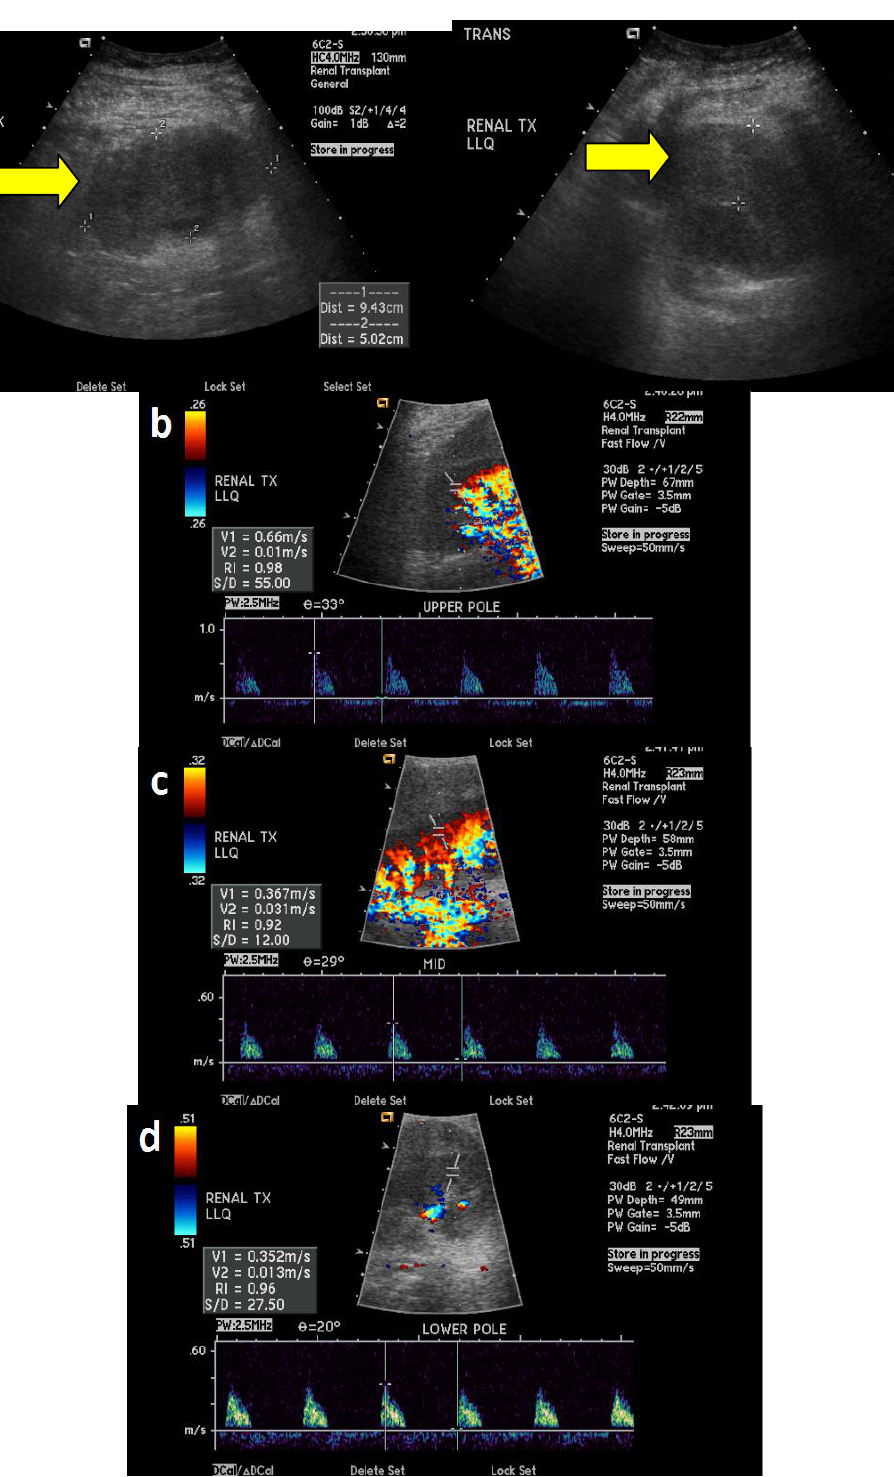
FIGURE 1. Transplant kidney ultrasound showing a large subcapsular perinephric concentric hematoma (a: marked by crosses and yellow arrows). Doppler studies showed increased resistive indices on the upper (b), middle (c), and lower (d) poles of the